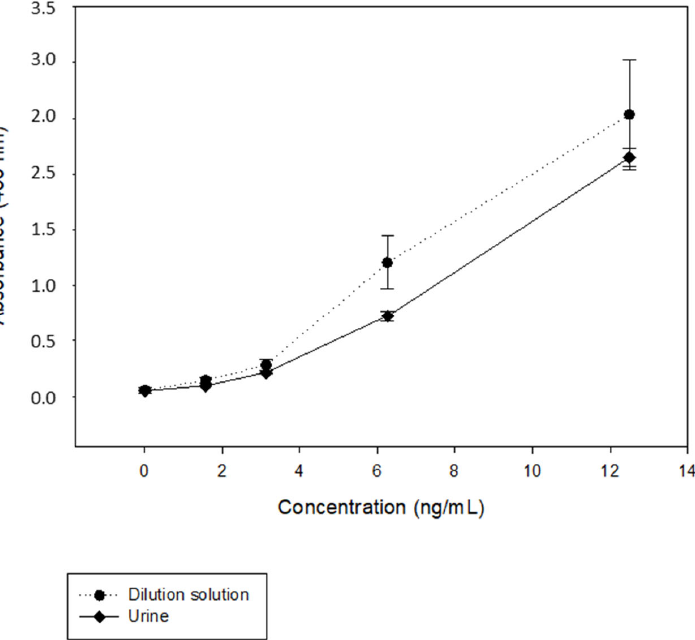
Figure 3. Standard curve for the quantification of the 33-mer used as reference material. The linear portion of the curve is between 12.5 and 1.56 ng/mL. The solid black line represents the mean values and standard deviations (SD) of 12 determinations per concentration in the urine matrix and the dashed line in the dilution solution.